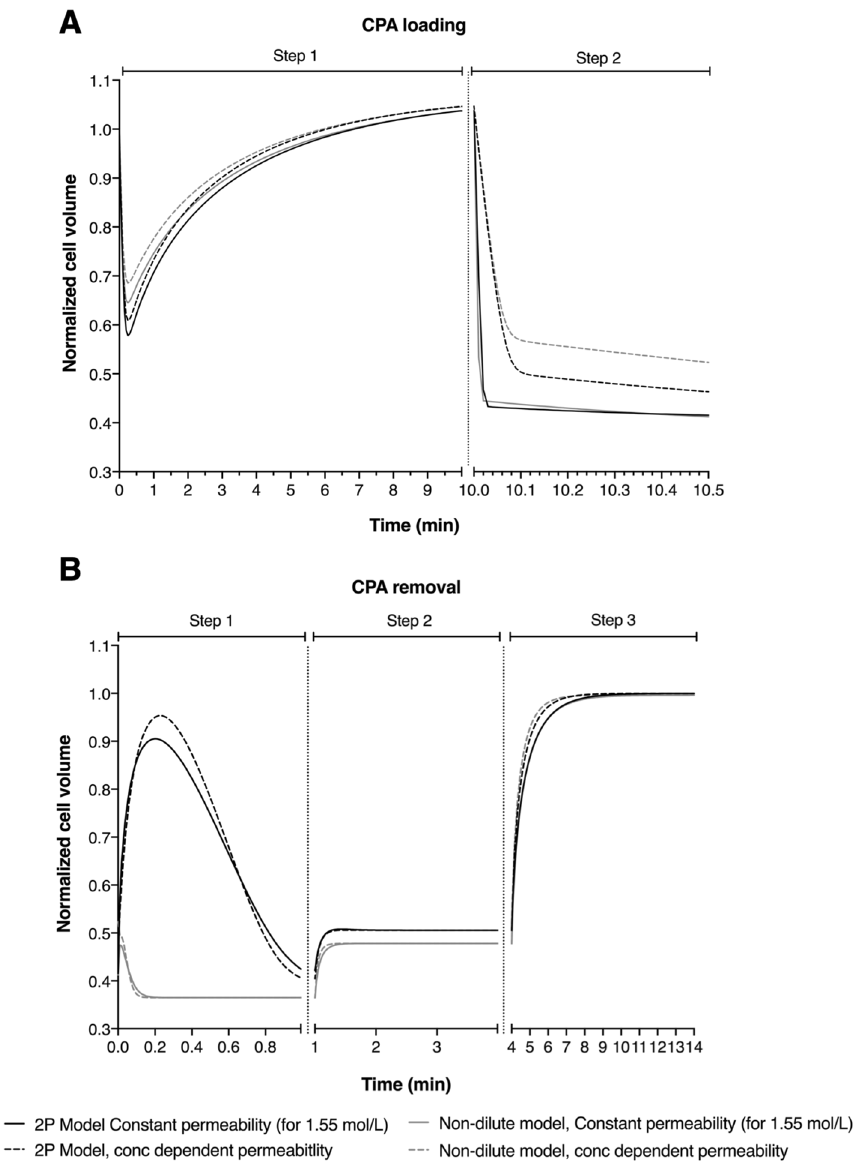
Figure 5. Comparative simulation of cell volume excursion of MII-stage bovine oocytes during CPA addition ( A ) and removal ( B ) following the Kuwayama protocol for the 2P model (black line) and nondilute model (gray line) using constant (solid line) and non-constant permeability parameters (dotted